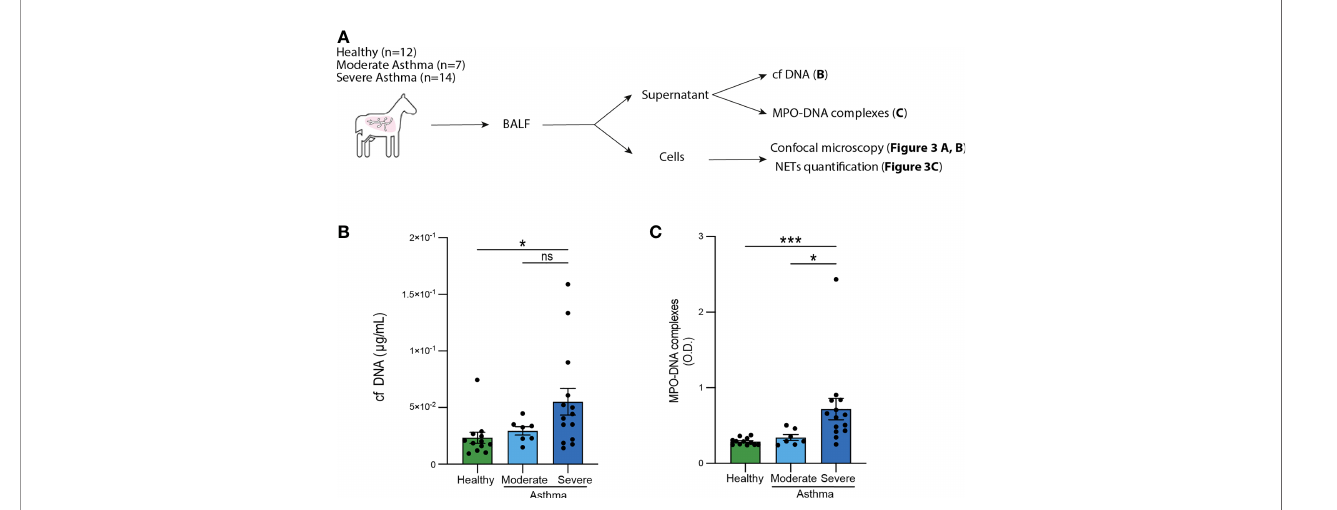
FIGURE 2 | Elevated levels of cf DNA and MPO-DNA complexes in BALF from severe asthmatic horses. (A) Experimental Outline. BAL were performed, cytospins were processed and analyzed by confocal microscopy, while supernatants were recovered to measure cf DNA and MPO-DNA complexes. (B) BALF cf DNA content measured by PicoGreen assay. (C) BALF MPO-DNA complexes measured by ELISA. (B, C) Data show mean+/-s.e.m., as well as individual horses (healthy n=12; moderate asthma n=7; severe asthma n=14). P values were estimated with a one-way ANOVA with Kruskal-Wallis ’ post hoc test. * , P <0.05; ***, P <0.001; ns, not signi fi